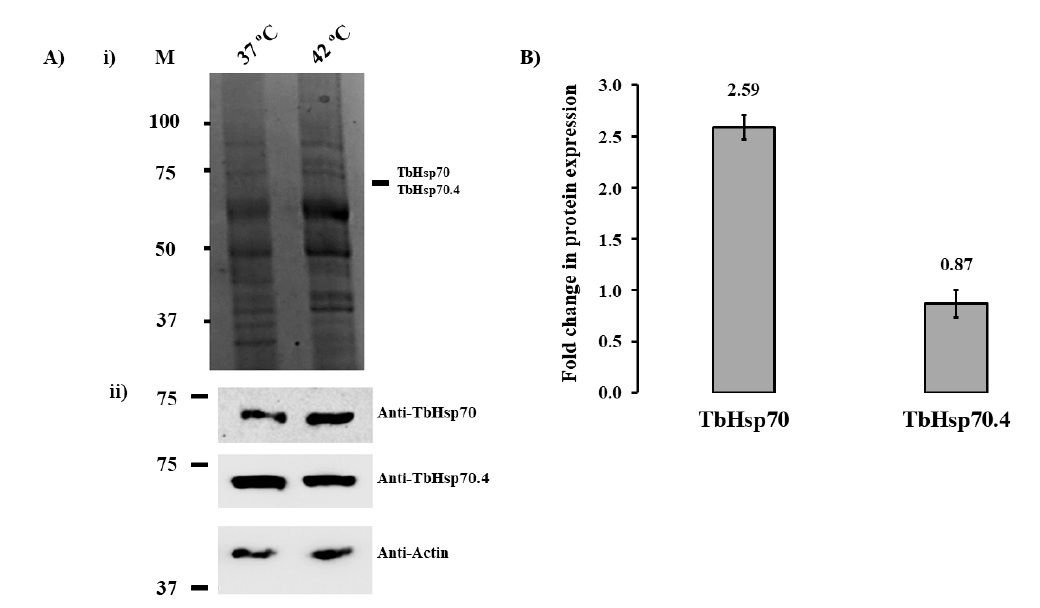
Figure 2. Expression of TbHsp70 and TbHsp70.4 in T. b. brucei parasites is modulated in response to heat stress at the blood stage. ( A ) (i) SDS-PAGE (10%) and (ii) Western blot analyses of the expression of TbHsp70 and TbHsp70.4 by T. b. brucei parasites cultured under normal (37 °C) and heat shock (42